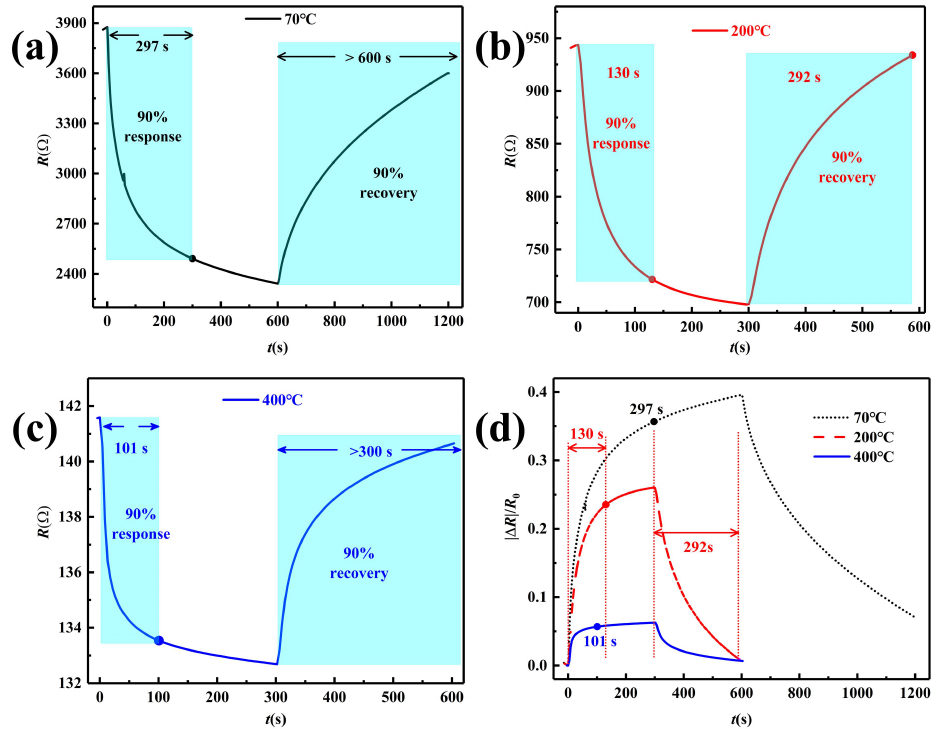
Figure 7. Response and recovery curves of sensors toward 50 ppm NO 2 . ( a – c ) Real-time resistance curves of sensors annealed at 70, 200, 400 ◦ C, ( d ) real-time response curves. Table 1. Response and recovery time of sensors with different annealing temperatures to 50 ppm NO 2 . Annealing Temperature ( ◦